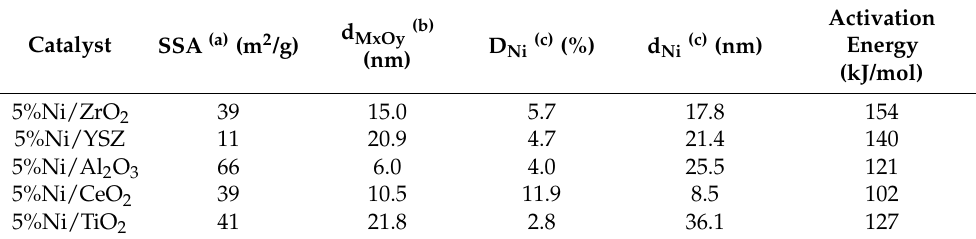
Table 1. Physicochemical properties of supported Ni (5 wt.%) catalysts and their apparent activation energies for propane steam reforming reaction.